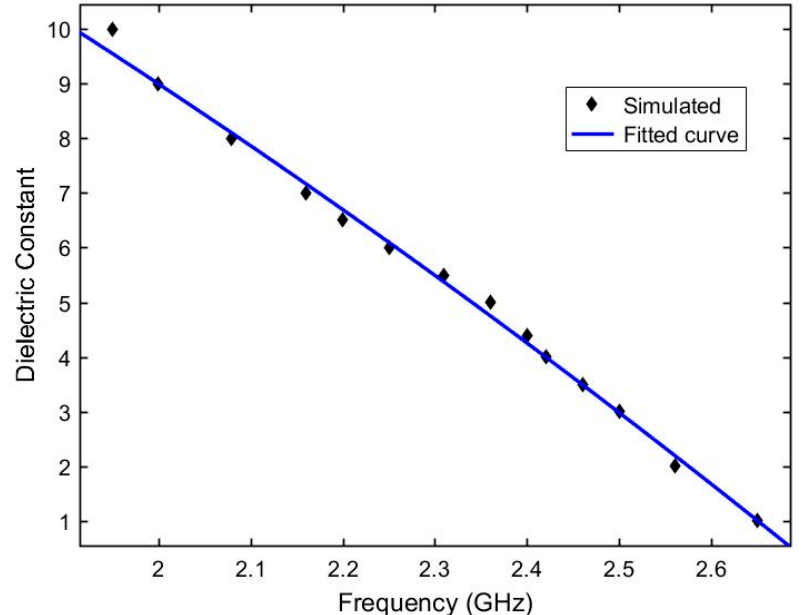
Figure 10. Simulated results and curve fitting for permittivity variation as a function of frequency.